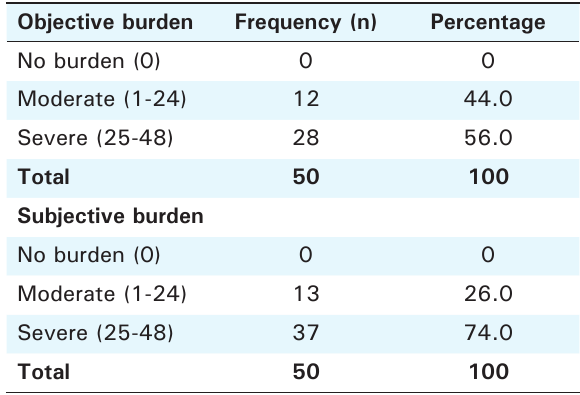
Table 5. Family burden (Objective) perceived by